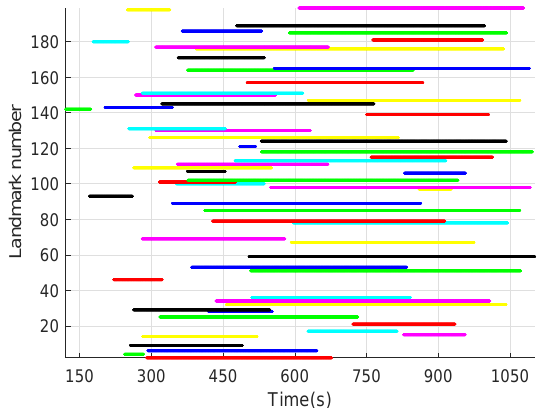
Figure 5. Landmark observation episodes.